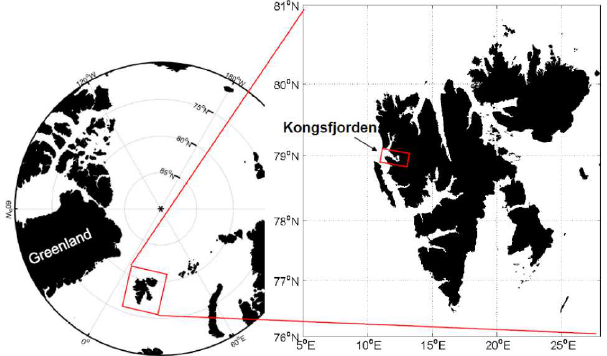
Figure 1 Fig. 1. Map of the Arctic Ocean with the Svalbard archipelago high- lighted in red and enlarged map of the latter with a red square indi- cating the location of